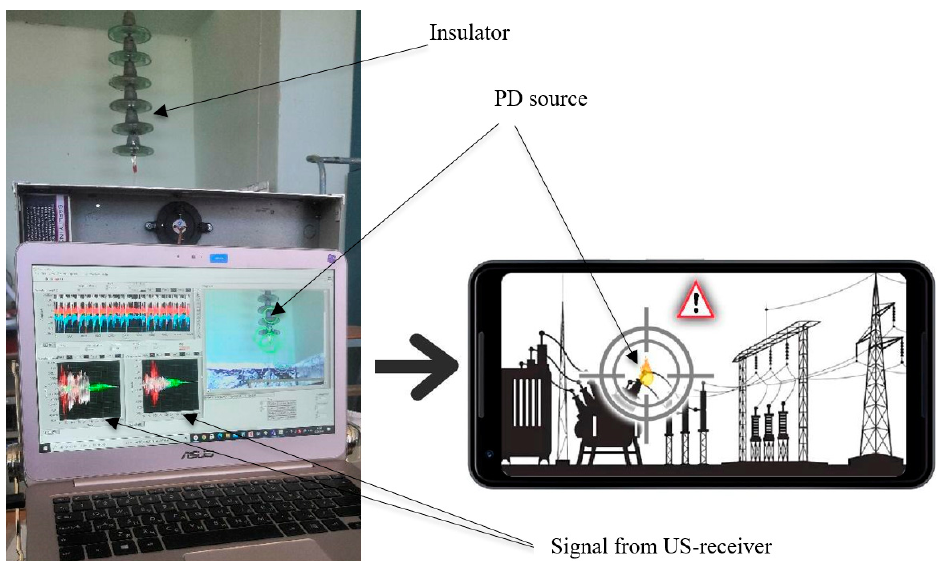
Figure 3. Flowchart the use of a portable device.